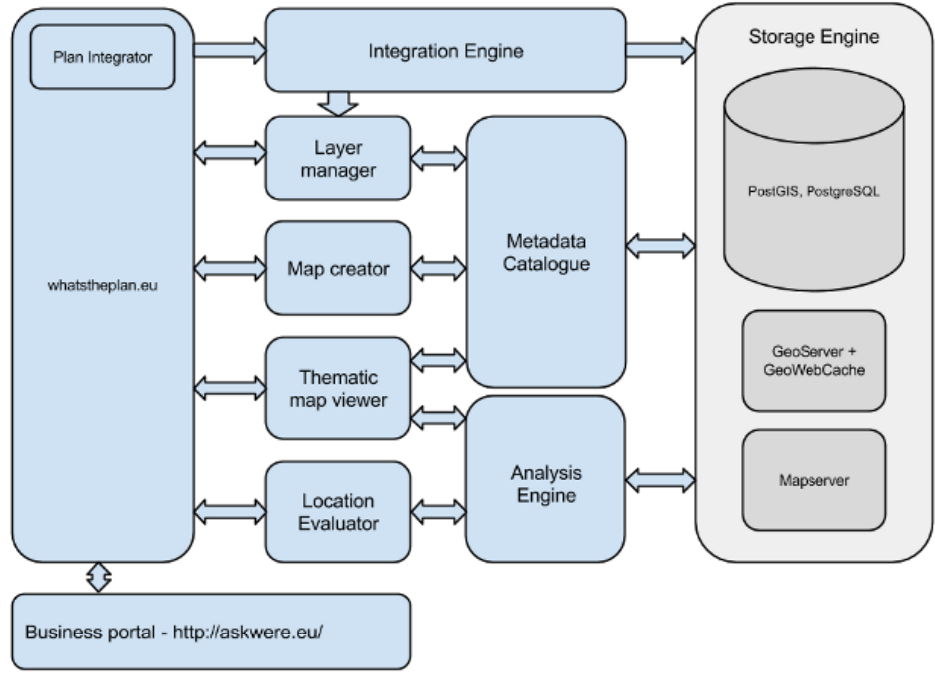
Figure 3. Plan4Business Platform Scheme [56].